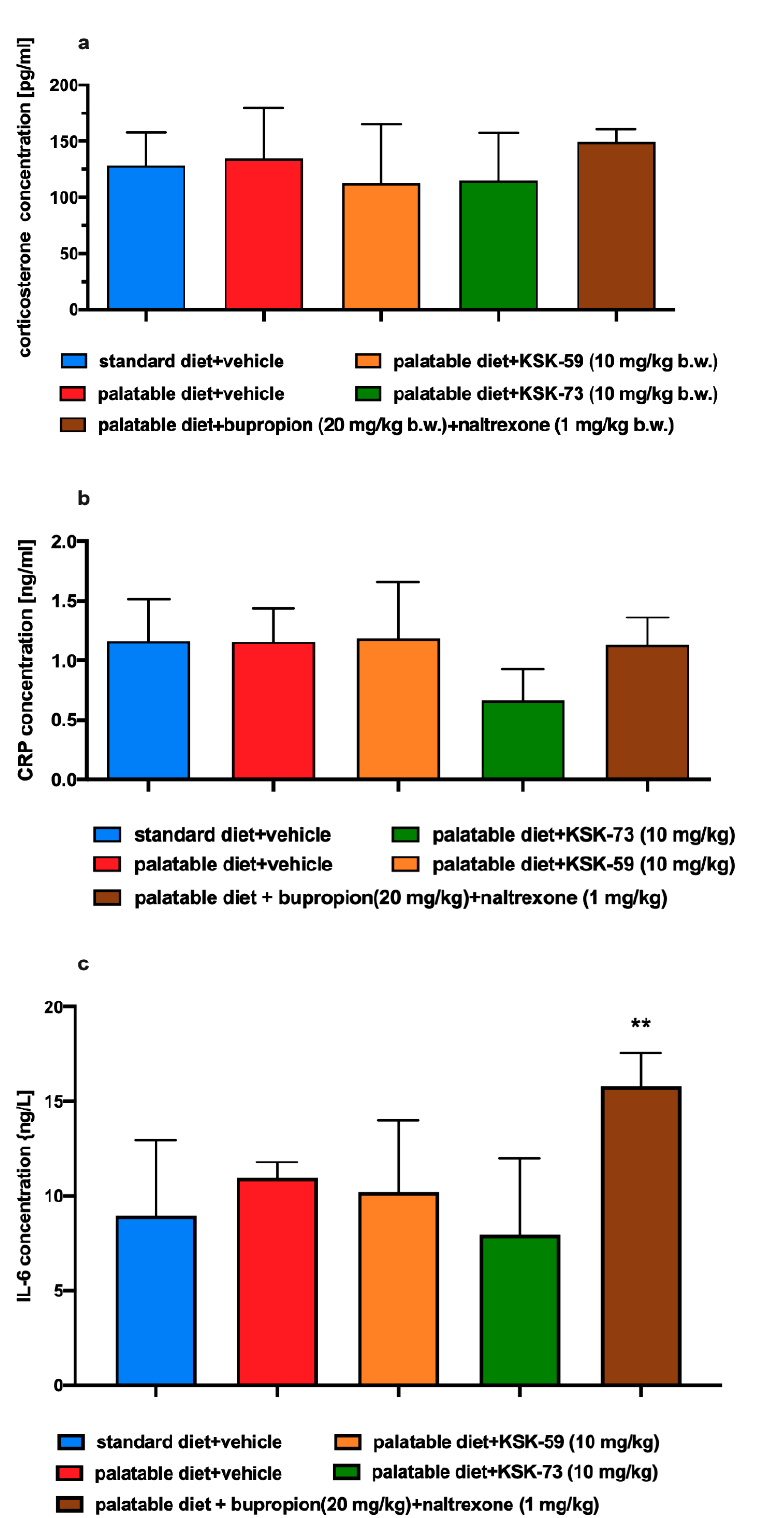
Figure 10. Effect of an administration of the tested compounds or bupropion/naltrexone on plasma levels of: ( a ) corticosterone, ( b ) CRP, and ( c ) IL-6. Results are expressed as means ± SEM, n = 6. Comparisons were performed by one-way ANOVA, Tukey’s post hoc test; * significant against control rats fed standard diet; ** p <